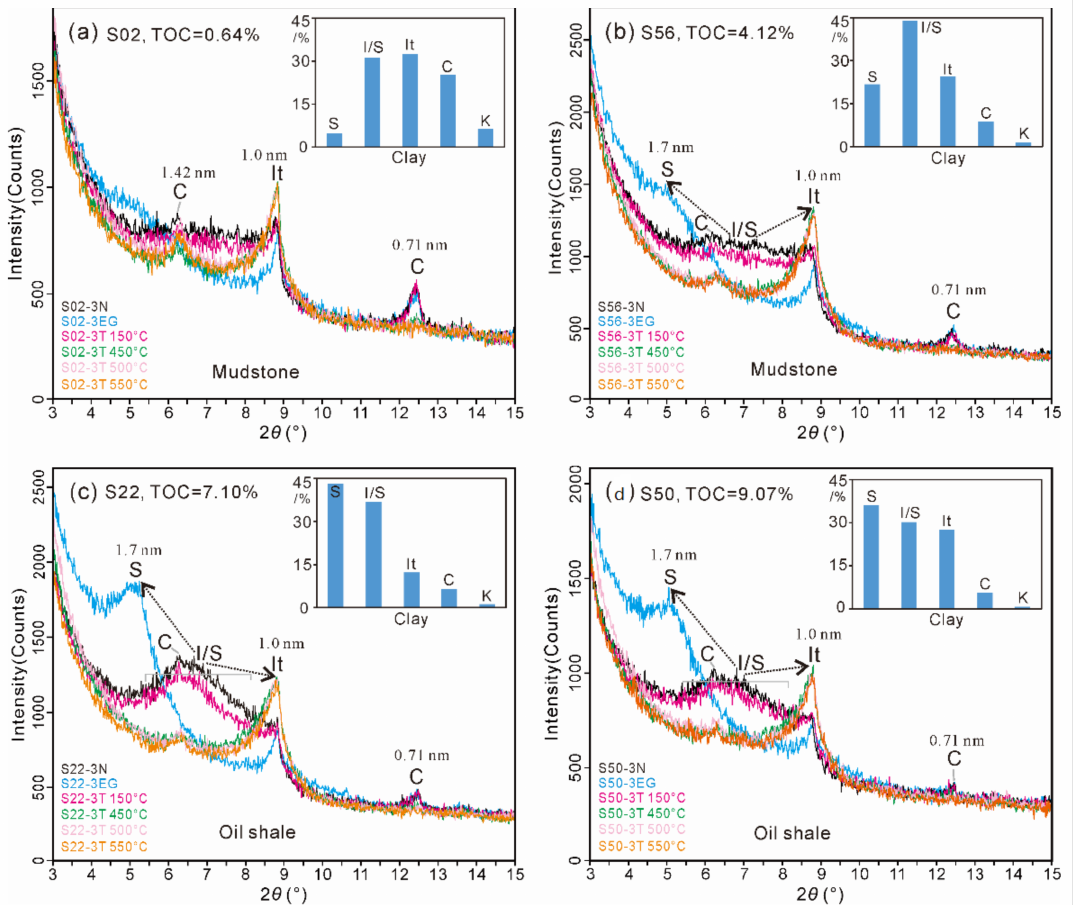
Figure 8. XRD patterns with mineral contents from selective clay minerals of oil shales and mudstones by various heat treatments, including natural oriented (N), ethylene glycol-saturated (EG), and high temperature (T 150 ◦ C, T 450 ◦ C, T 500 ◦ C, and T 550 ◦ C), exhibiting samples S02 ( a ), S56 ( b ), S22 ( c ), and S50 ( d ) in the K 2 qn 1